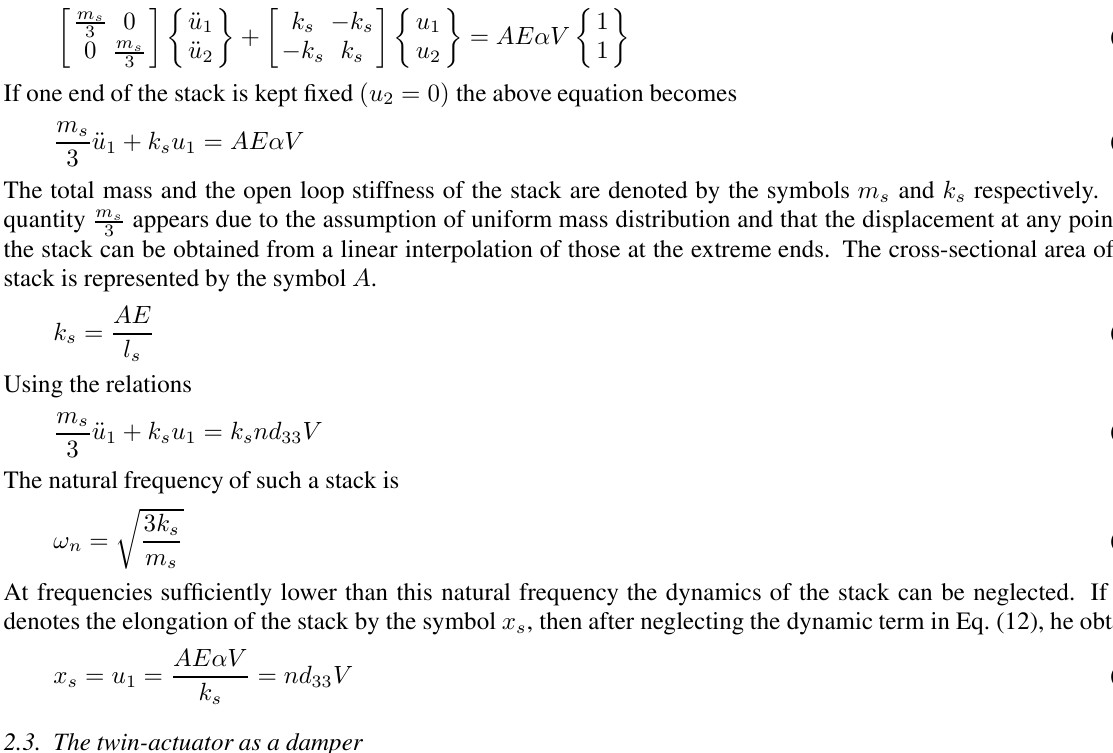
Fig. 4. An expected force-gap characteristics for two permanent magnets when the beam is kept fi xed.